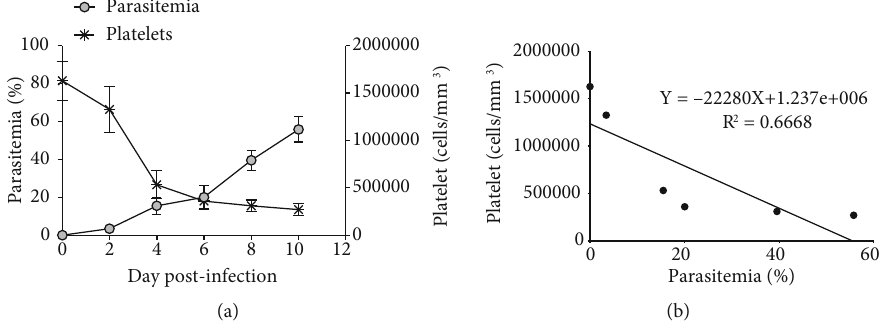
Figure 1: PbANKA-induced thrombocytopenia. ICR mice were infected with 1 × 10 7 parasitized RBC of PbANKA by intraperitoneal injection. (a) Parasitemia and platelet count were monitored. (b) Correlation between parasitemia and platelet count was also observed. Results were presented as mean ± SEM .